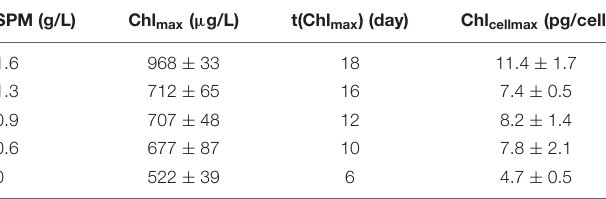
TABLE 5 | The maximum Chl- a concentration (Chl max ), time of the occurrence of Chl max [t(Chl max )], and the maximum cellular Chl- a content (Chl cellmax ) of A. carterae in the single-factor SPM experiment.